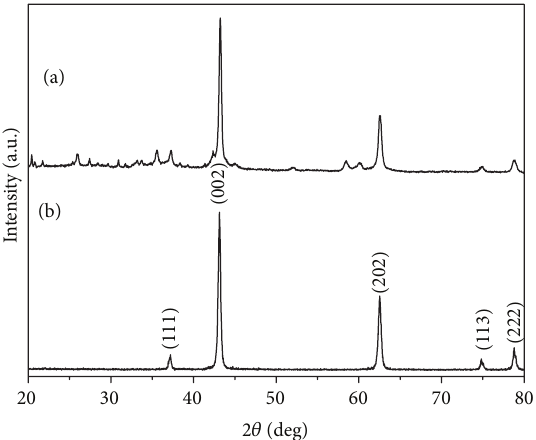
Figure 3: XRD patterns of as-prepared (a) and annealed (b) MgO nanoparticles.